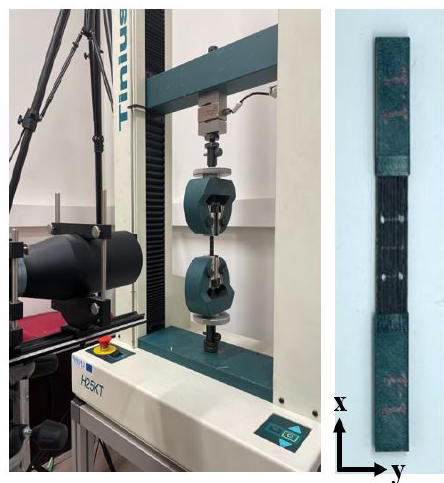
Figure 4. Experimental setup of tensile testing.